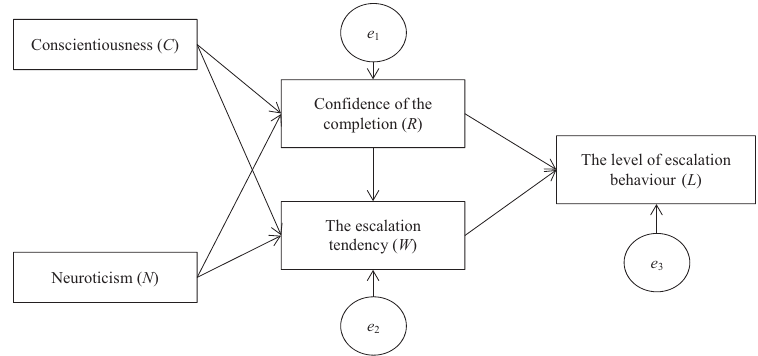
Figure 1. Conceptual model for the paths of investors’ EOC in